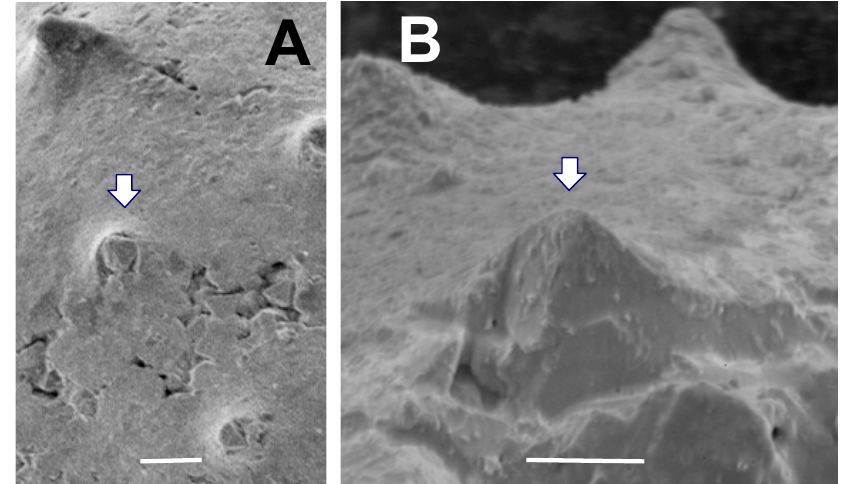
Figure 12. Close-up of several spines of a Tully acanthomorph (TYS-43).Arrows point to the same spine in both A and B. ( A ) Spines viewed from directly above vesicle surface. Spine indicated by arrow contains a stack of large pyrite crystals growing up from vesicle interior. Scale bar = 10 µ m; ( B ) Close-up of this spine shows the open spine interior filled with pyrite crystals inside it, and with no obvious vesicle wall or partition within the spine. Scale bar = 10 µ